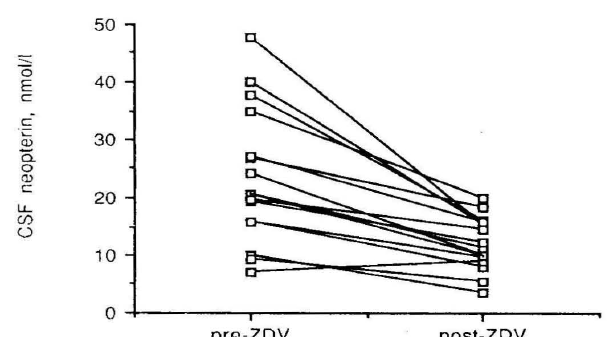
Figure 2 _ Concentrations of neopterin in cere brospinal fluid before, and after 6 to 12 months on, zidovudine (ZDV) treatment in 14 HIV-po sitive patients without neurological symptoms. tients with cerebral toxoplasmosis, as compared to 21 nmol/l in patients with HIV encephalopathy,